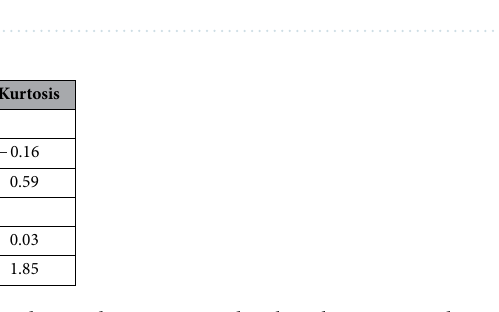
Table 4. Descriptive statistics for the computed BP and WR associated with each picture condition for experiment 2.